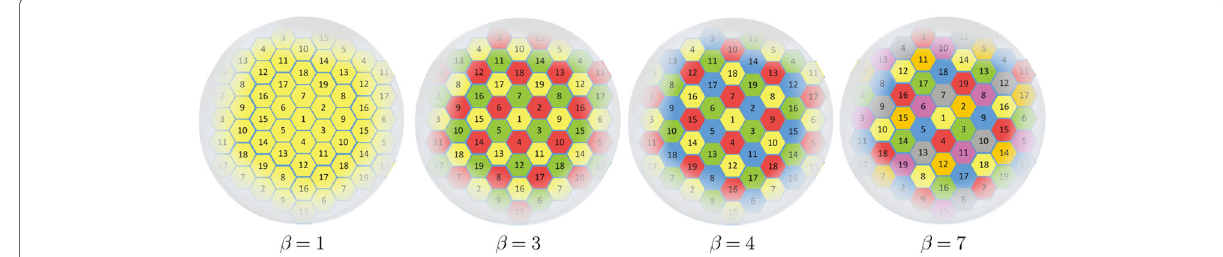
Fig. 1 The 19-cell-wrap-around hexagonal network topology for β = 1, β = 3, β = 4, and β =